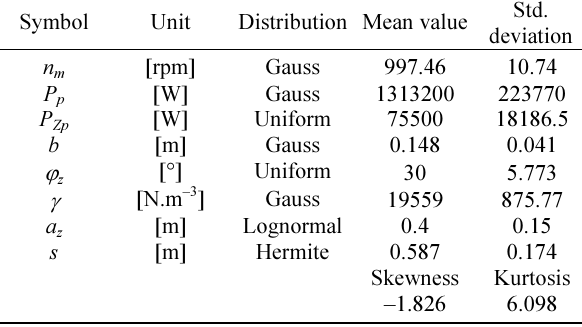
Table 5. Random variables for the fourth terrace